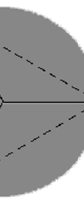
Figure 1. Sample representation divided into three parts. Coatings 2022 , 12 , x FOR PEER REVIEW